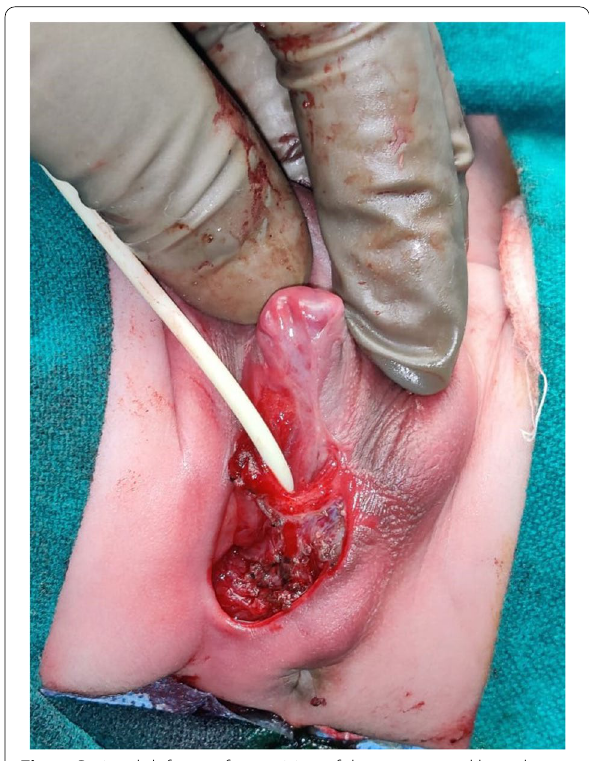
Fig. 4 Perineal defect—after excision of the sequestered bowel loops